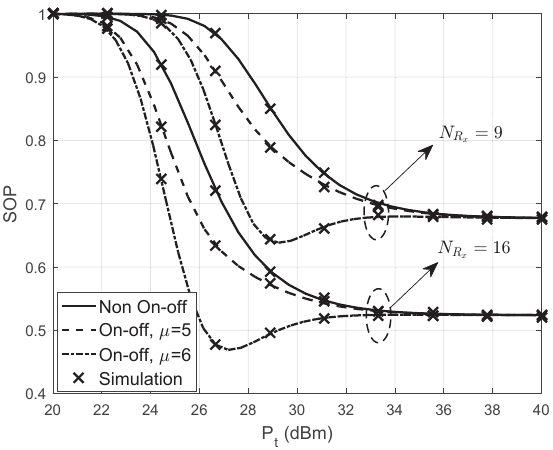
Figure 5. The SOP versus the transmit power P t when H = 120 m, C th = 4, C s = 1, λ R = 1 × 10 − 3 , and λ E = 2 × 10 − 3